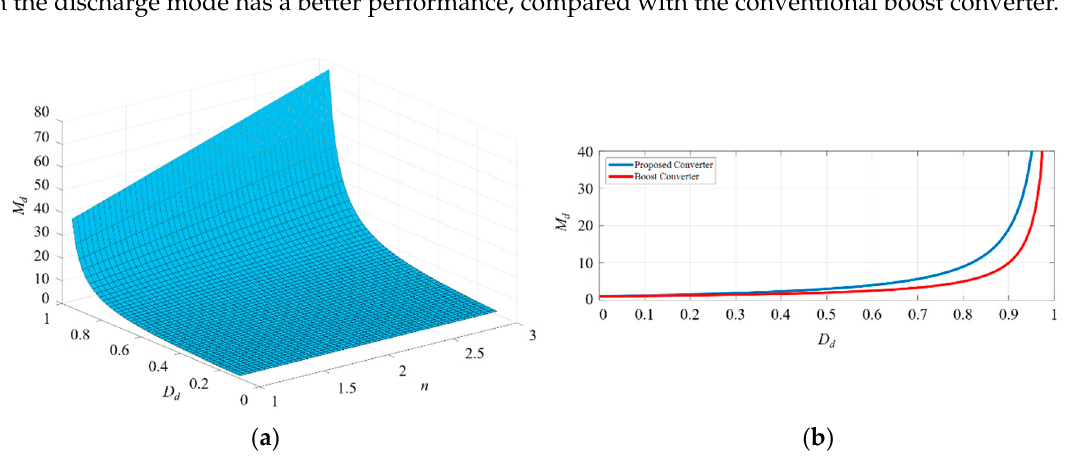
Figure 8. Converter characteristics in discharge mode: ( a ) relationship diagram of M d , D d , and n ; ( b ) relationship diagram of M d and D d ( n = 1).